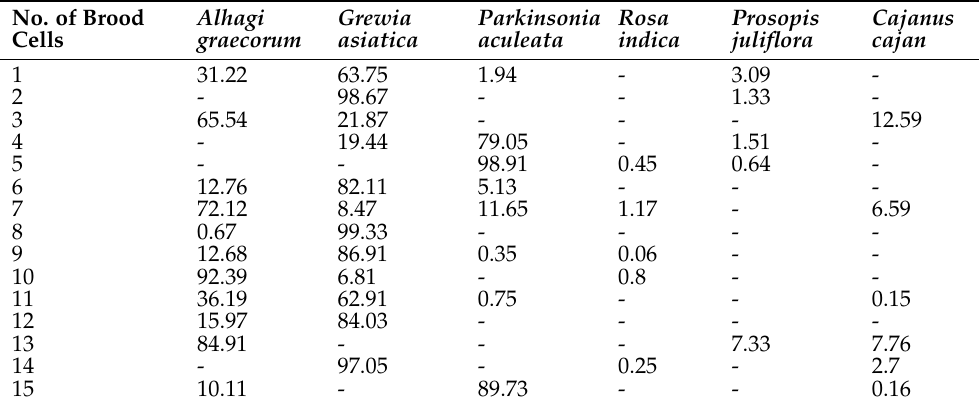
Table 4. Percentage of pollen types used by Megachile cephalotes .